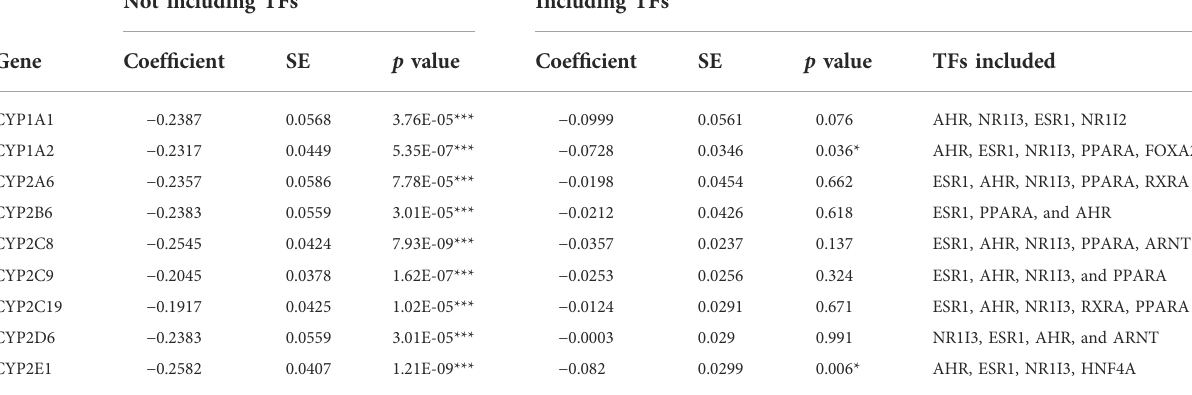
TABLE 4 Association between expression levels of miR-107 and nine CYP genes in human liver samples ( n = 231) using linear regression analysis with or without adjusting for transcription factors as indicated. Age, sex, and race were included as covariates in all analysis. Not including